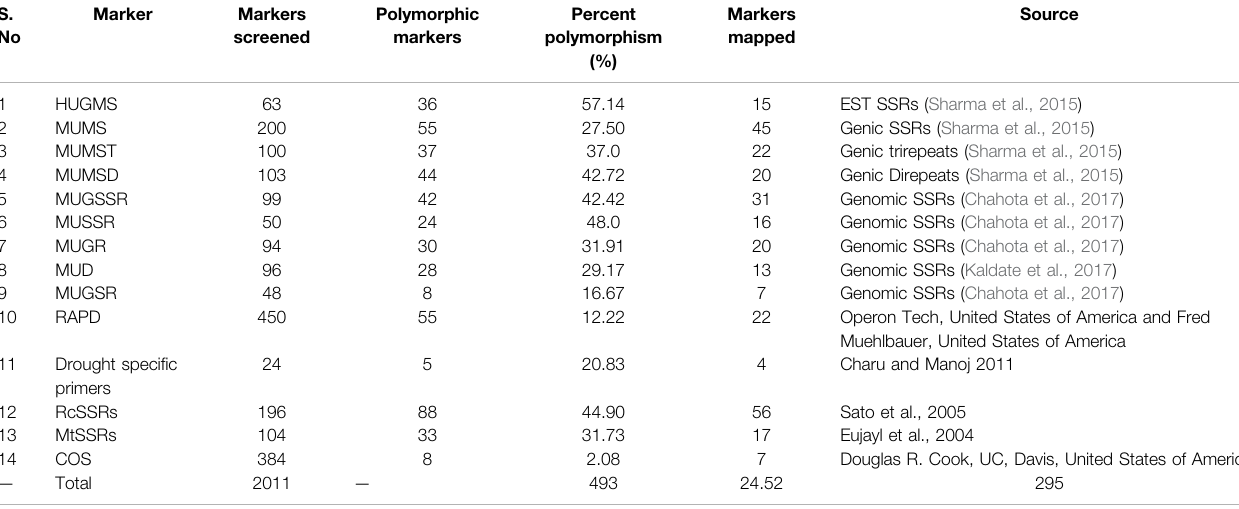
TABLE 4 | List of molecular markers used for construction of linkage map of horsegram. Marker